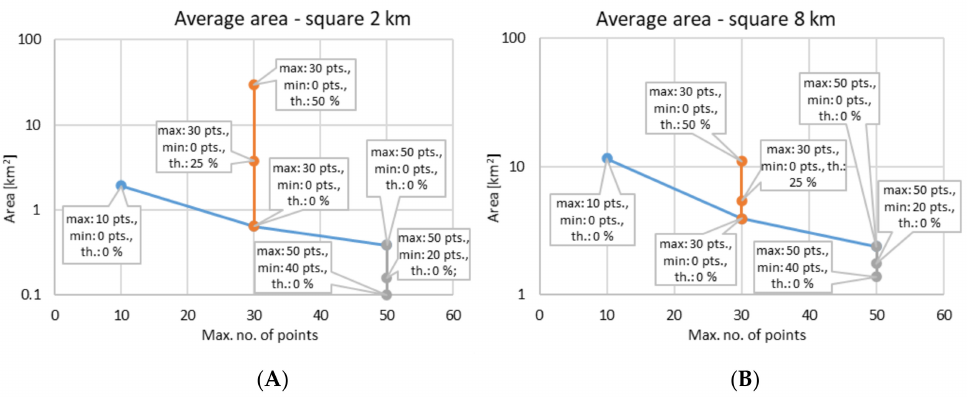
Figure 9. Diagrams of the changes in the average surface area for squares: ( A )—2 × 2 km, ( B )—8 × 8